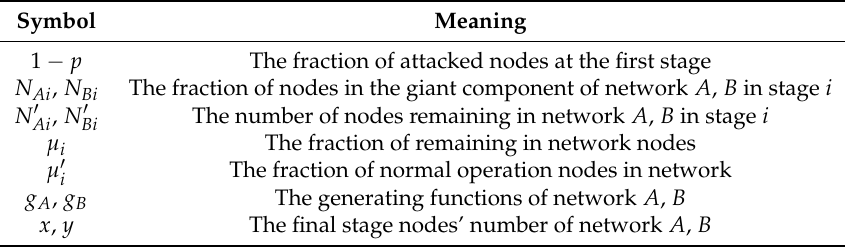
Table 2. Key notations in the analysis of cascading failures